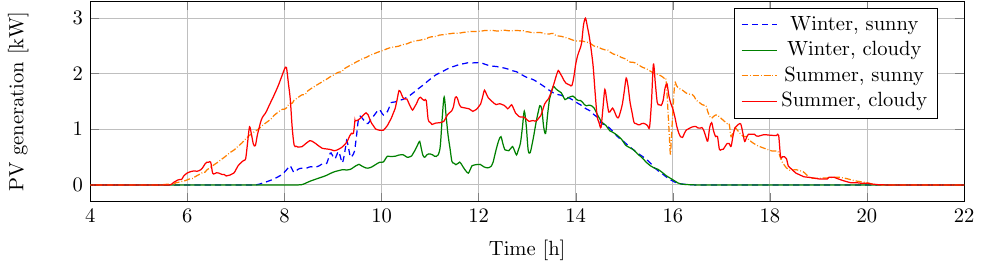
Figure 3. PV generation profiles for the four scenarios. The higher generation at 8 a.m. on a cloudy summer day (red line) compared to a sunny summer day (orange, dashed) comes from the efficiency increase caused by the cooling (a possible cloud passing by) at 7 a.m.